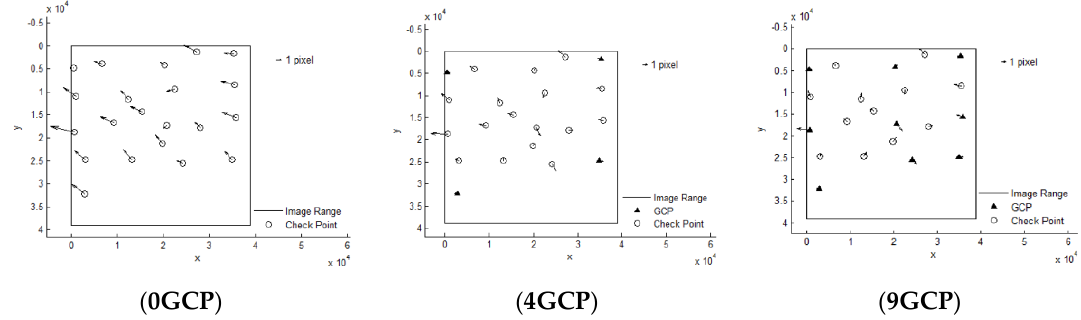
Figure 4. Residual distributions of check points of orientation for Pleaides.